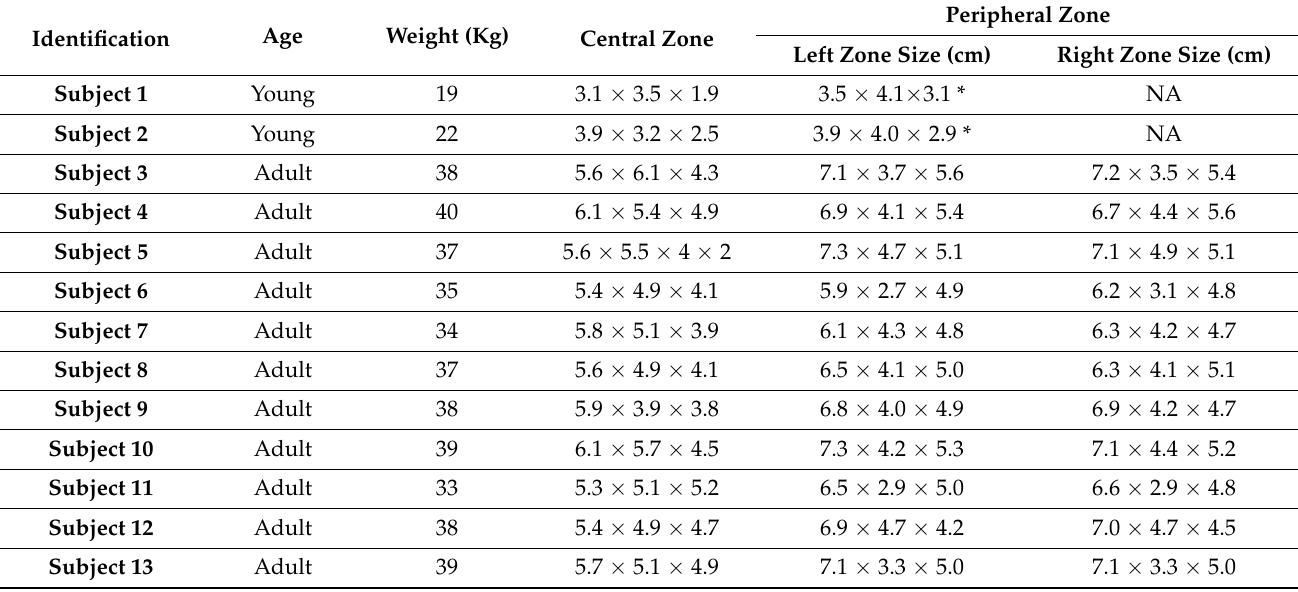
Table 1. Giant anteater autopsied